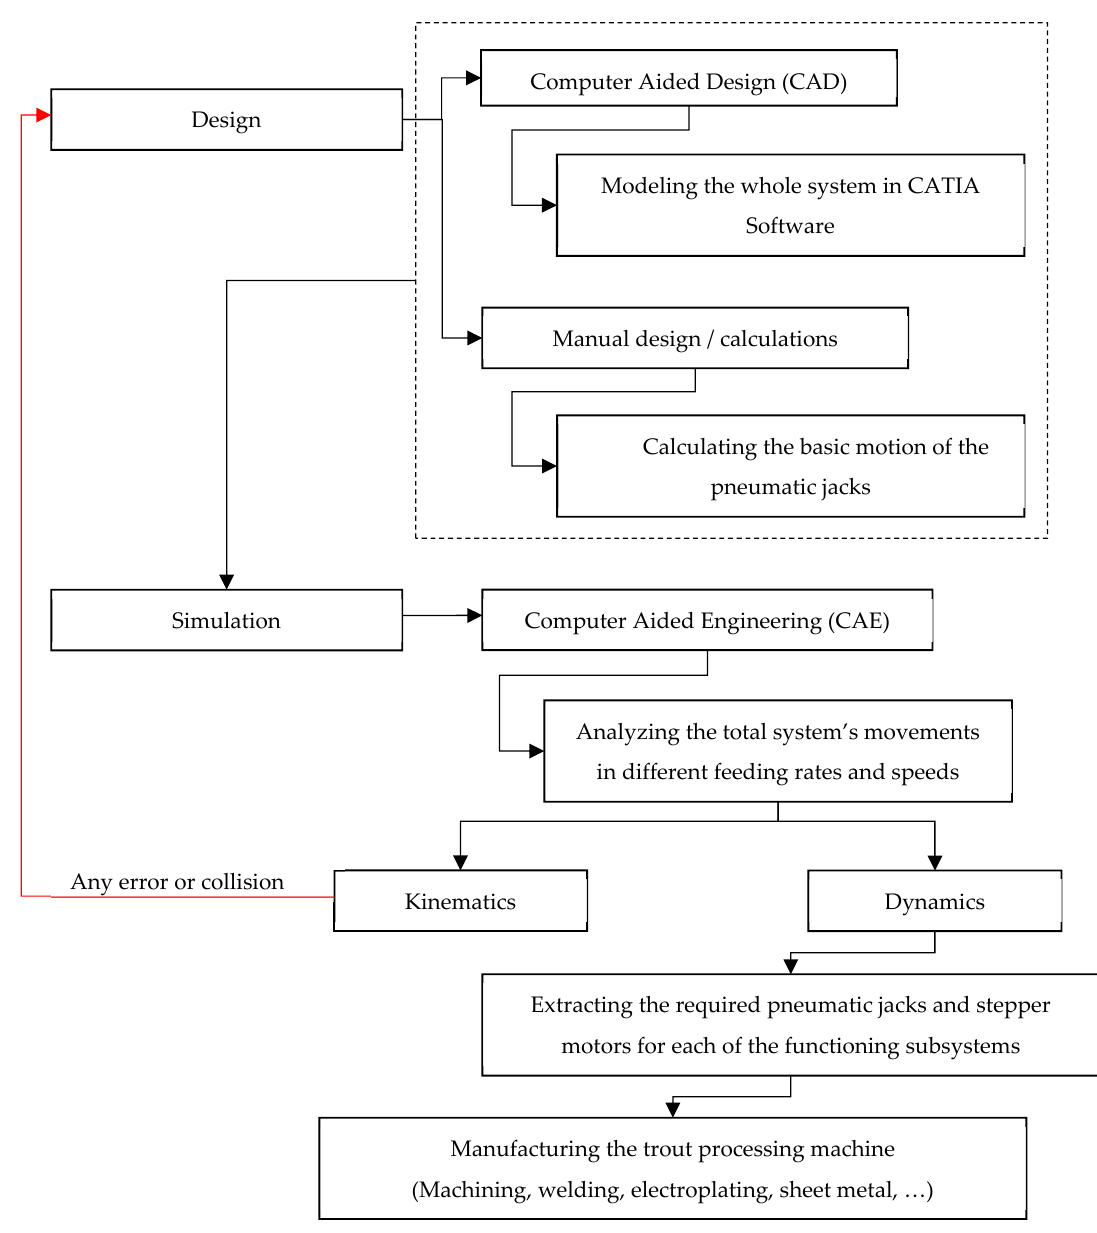
Figure 3. The design rationale of the trout-processing system with applied methods and software.